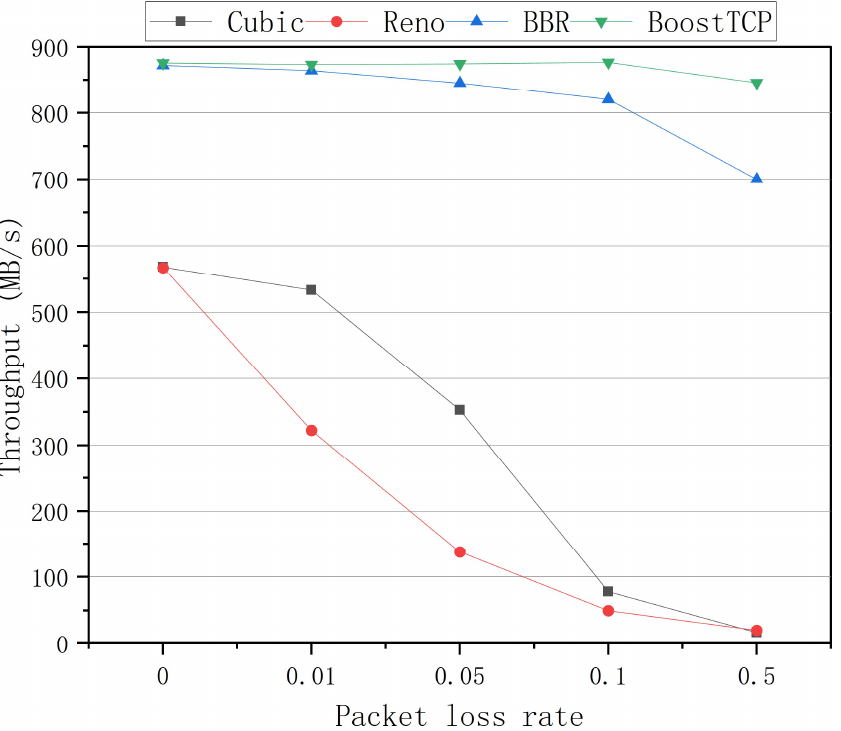
Figure 5. The throughput curves of the four congestion control algorithms as a function of the packet loss rate at a network delay of 20 ms.